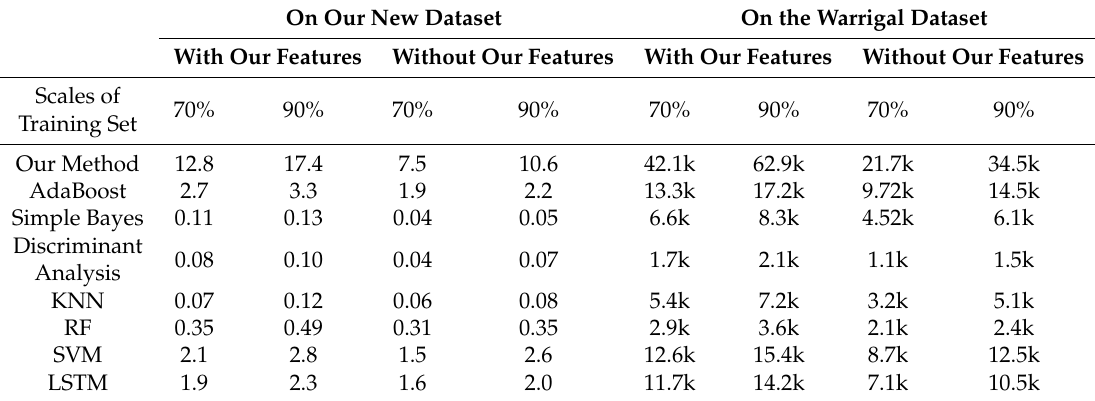
Table 10. A summary of the training time required for the methods compared in seconds. On Our New Dataset